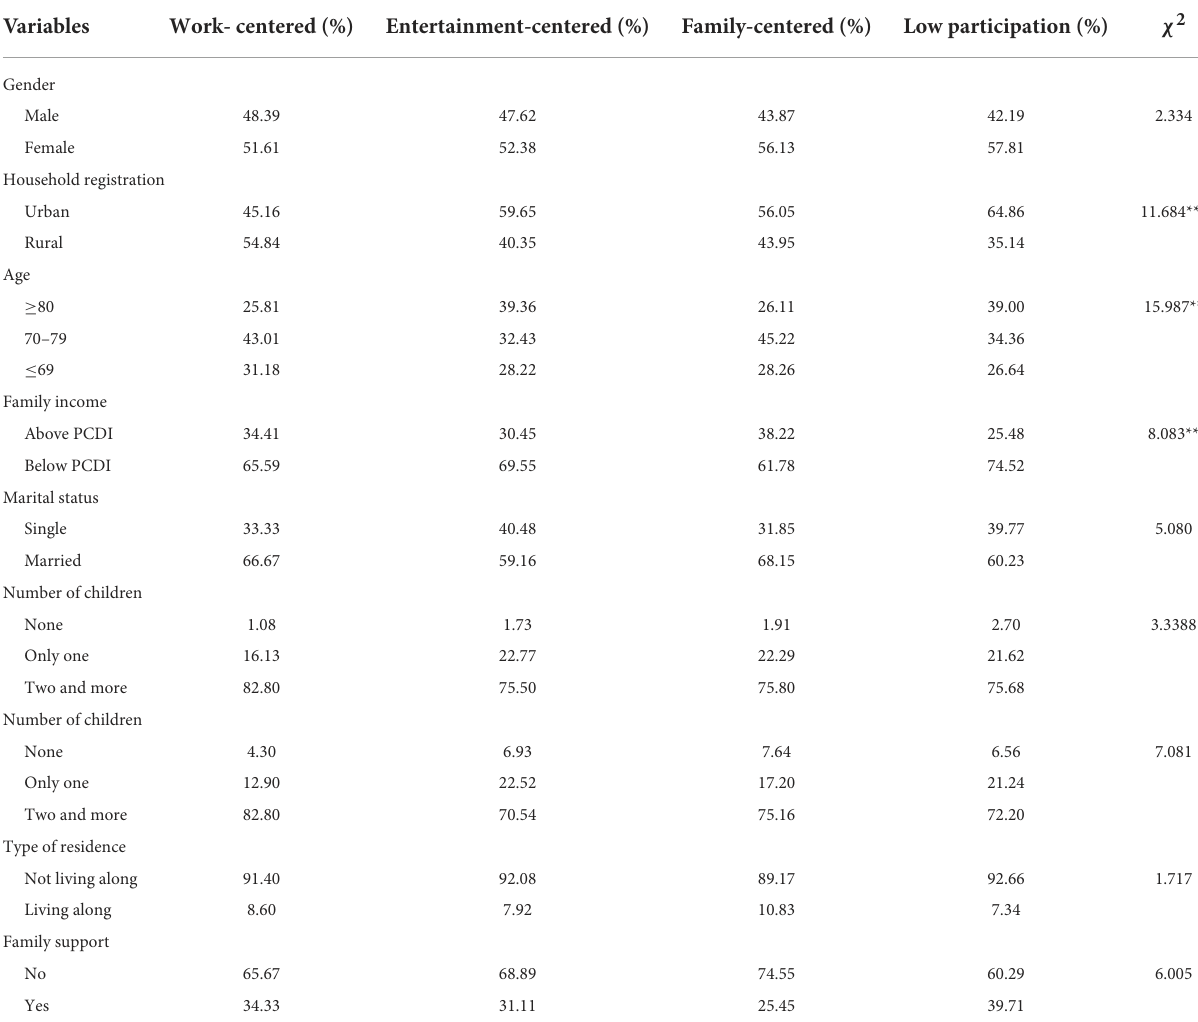
TABLE 6 Group differences in social participation of the elderly ( N =